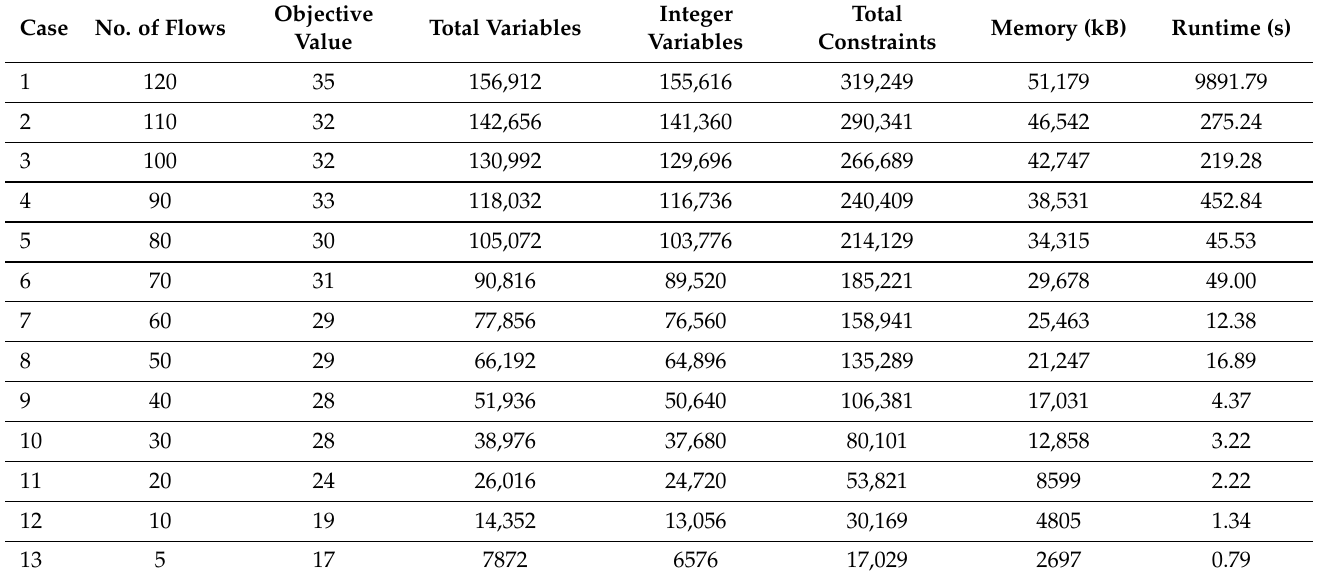
Table 3. LinGo test